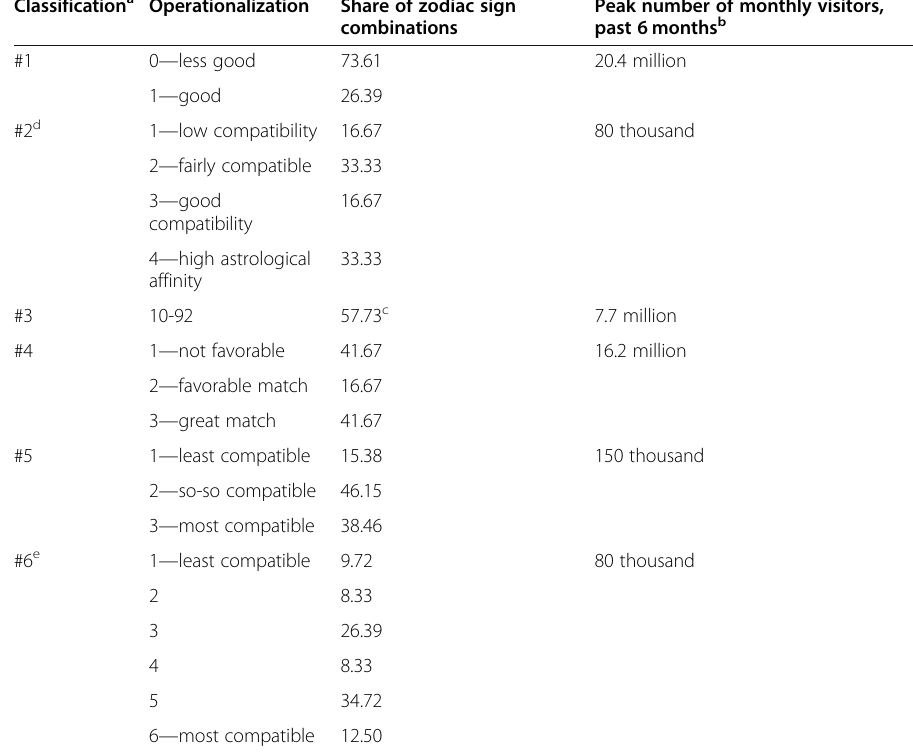
Table 1 Zodiac-sign compatibility classifications Classification a